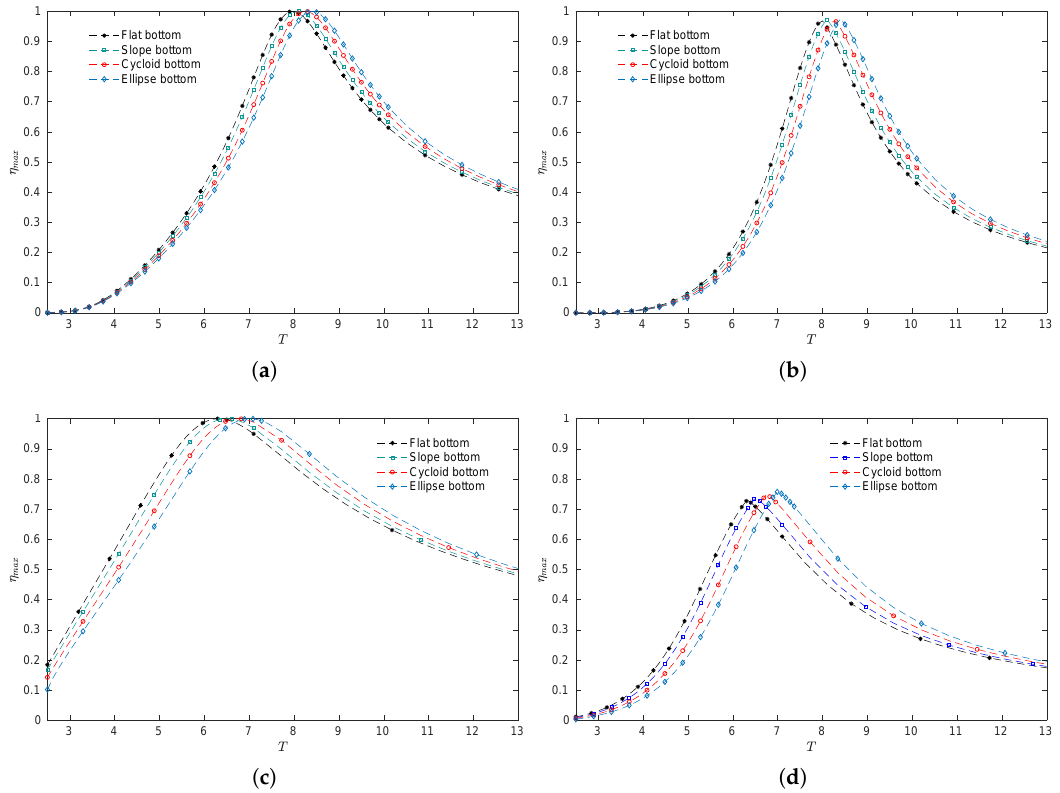
Figure 13. Hydrodynamic efficiency in the cases of HEST and LEST versus T for different bottom profiles. ( a ) Maximum efficiency versus T with (cid:36) = 0 for various bottom profiles with h = 7.90, h a / h = 0.646, b / h = 0.392 and w / b = 2.145 in the case of the HEST. ( b ) Maximum efficiency versus T for various bottom profiles with h = 7.90, h a / h = 0.646, b / h = 0.392 and w / b = 2.145. in the case of the HEST. ( c ) Maximum efficiency versus T with (cid:36) = 0 for various bottom profiles with h = 3.40, h a / h = 0.176, b / h = 0.392 and w / b = 2.145 in the case of the LEST. ( d ) Maximum efficiency versus T for various bottom profiles with h = 3.40, h a / h = 0.176, b / h = 0.392 and w / b = 2.145 in the case of the